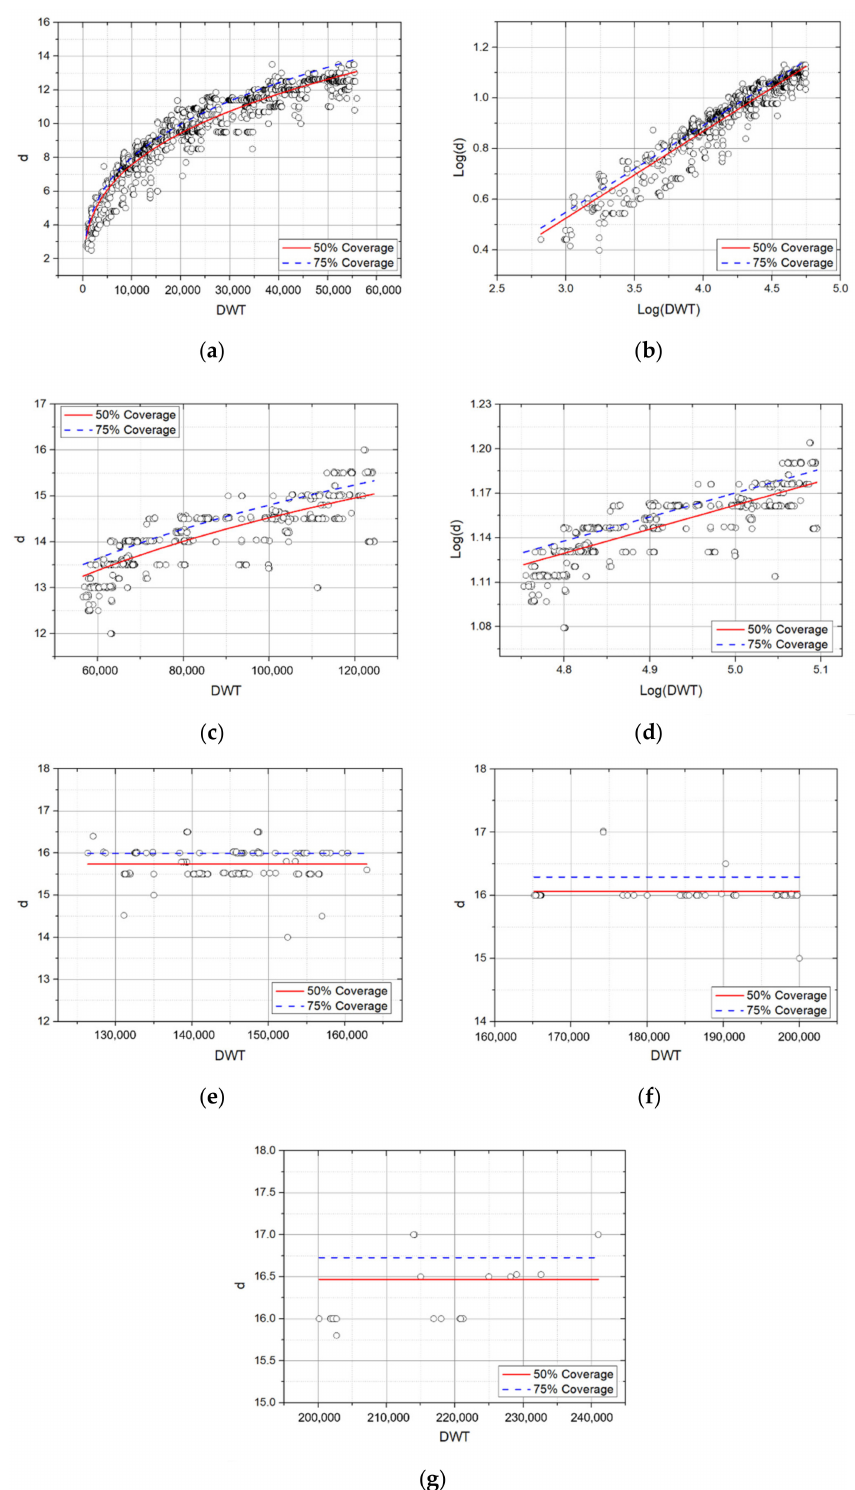
Figure 16. Results of regression analysis. ( a ) Deadweight tonnage (DWT)-draft (d) graph of Cluster 1 (0–55,000 DWT); ( b ) Log(DWT)-Log(d) graph of Cluster 1 (0–55,000 DWT); ( c ) DWT-d graph of Cluster 2 (55,000–125,000 DWT); ( d ) Log(DWT)-Log(d) graph of Cluster 2 (55,000–125,000 DWT); ( e ) DWT-d graph of Cluster 3 (125,000–165,000 DWT); ( f ) DWT-d graph of Cluster 3 (165,000–200,000 DWT); ( g ) DWT-d graph of Cluster 3 (200,000–241,000